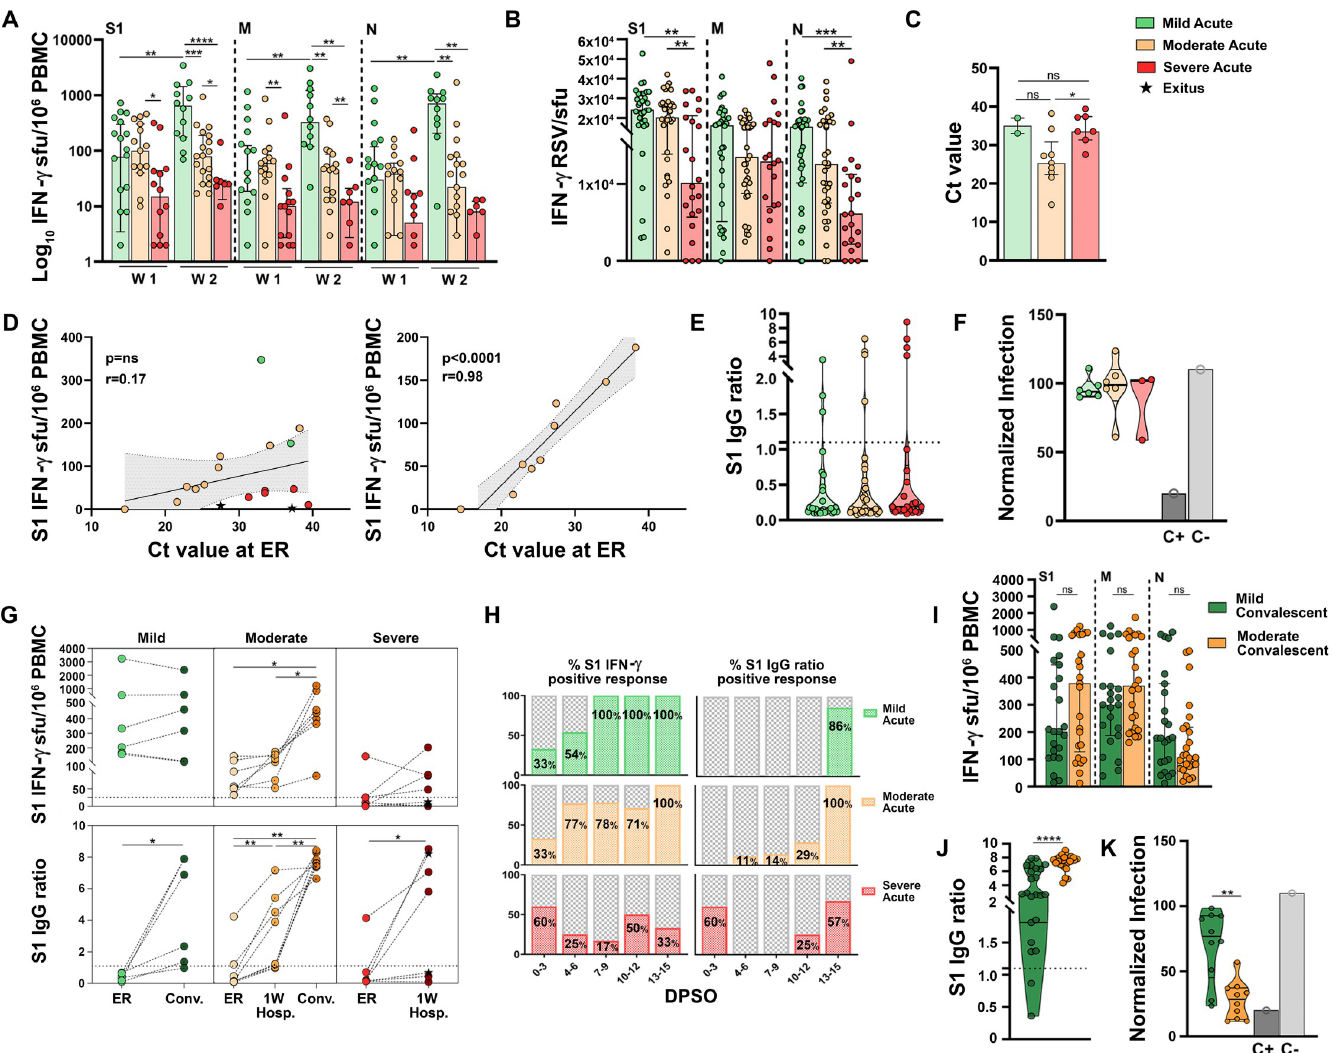
Fig 5. Association between dynamics of SARS-CoV-2-specific immune responses and COVID-19 severity. ( A ) SARS-CoV-2-specific IFN- γ -producing T-cell responses reactive to the S1, M and N proteins in mild, moderate, and severe patients during the first (W1) and the second (W2) week post-symptom onset. ( B ) Relative Spot Volume (RSV) per spot of secreted IFN- γ after S1, M and N peptide pool stimulation in mild, moderate, and severe patients during acute infection. ( C ) Ct values obtained on real time RT-PCR for detection of the E gene upon arrival to ER in mild, moderate and severe patients. A higher Ct value corresponded to a lower viral load. ( D ) Correlation between S1 IFN- γ -producing T-cells and the relative viral load represented as Ct value at ER. ( E ) Semi-quantitative results of SARS-CoV-2 S1 IgG ELISA in the acute phase in mild, moderate, and severe patients. Dashed line represents the established cut-off of positivity (ratio � 1.1). ( F ) Neutralizing capacity tested with S protein-pseudotyped virus represented as normalized infection. ( G ) Longitudinal data on the dynamics of cellular and humoral responses in six representative patients from the 3 severity cohorts. ( H ) Percentage of positive S1 cellular and humoral response during acute phase according to the days post symptom onset (DPSO) in mild, moderate and severe patients. ( I ) Comparison of IFN- γ responses against SARS-CoV-2 S1, M and N proteins between mild and moderate patients in convalescent phase. ( J ) Comparison of semi-quantitative results of SARS-CoV-2 S1 IgG between mild and moderate patients in convalescent phase. ( K ) Comparison of neutralizing capacity tested with S protein-pseudotyped virus represented as normalized infection. Horizontal bars and whiskers represent median values and interquartile ranges, respectively. Linear regressions were performed using Spearman’s rank test. The significance between groups was determined using Mann Whitney, Wilcoxon signed rank or Kruskal-Wallis tests, � p < 0.05, �� p < 0.01, ��� p < 0.001, ���� p < 0.0001. ER: Emergency Room; Conv: Convalescence; 1W Hosp.: 1 Week Hospitalization; DPSO: Days post-symptom onset. https://doi.org/10.1371/journal.ppat.1010211.g005 Both SARS-CoV-2-specific IgG and neutralization were mostly undetectable in all 3 cohorts during the first 2 weeks of symptoms (Fig 5E and 5F). The different dynamics of cellular and humoral immune response development are shown with 6 representative patients from each of the 3 cohorts in Fig 5G. On the whole, the adaptive immune response seemed to be more